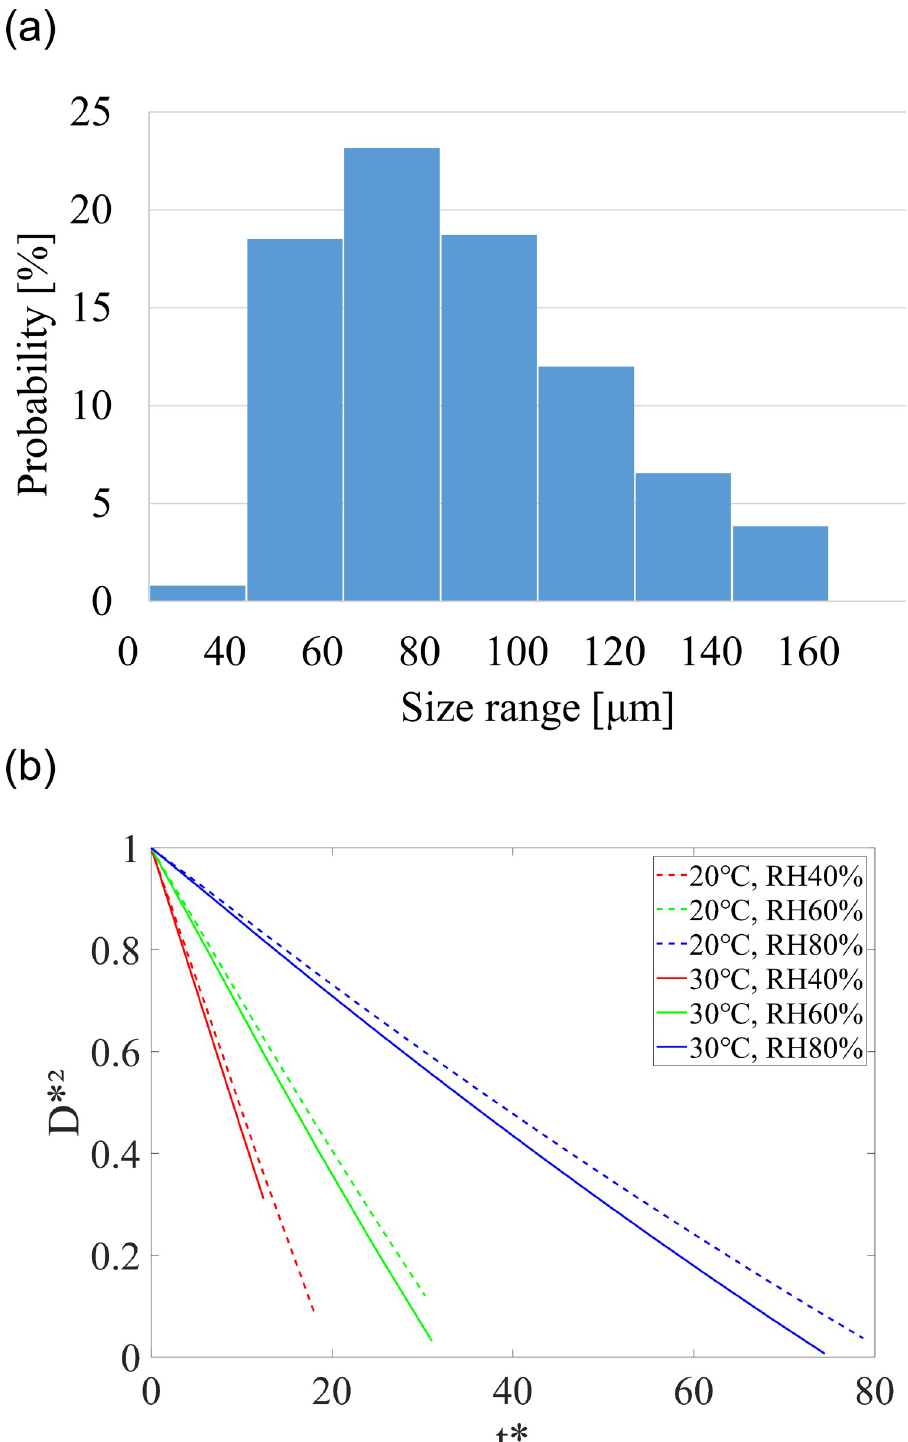
Fig 4. Droplet size distribution and evaporation rate. (a) Size distribution of initial cough droplets, (b) diameter change according to temperature and relative humidity for 70 μ m initial droplet.